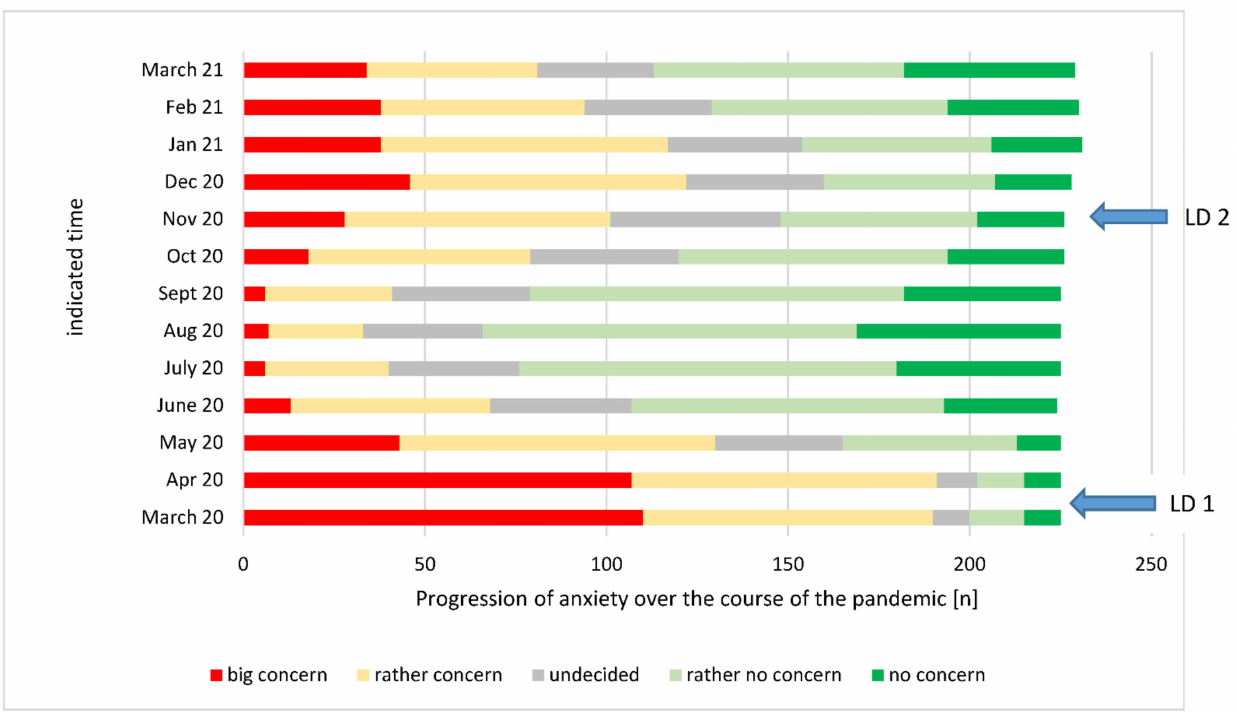
Figure 6. Reported anxiety for self-infection on a Likert scale during the period from March 2020 to March